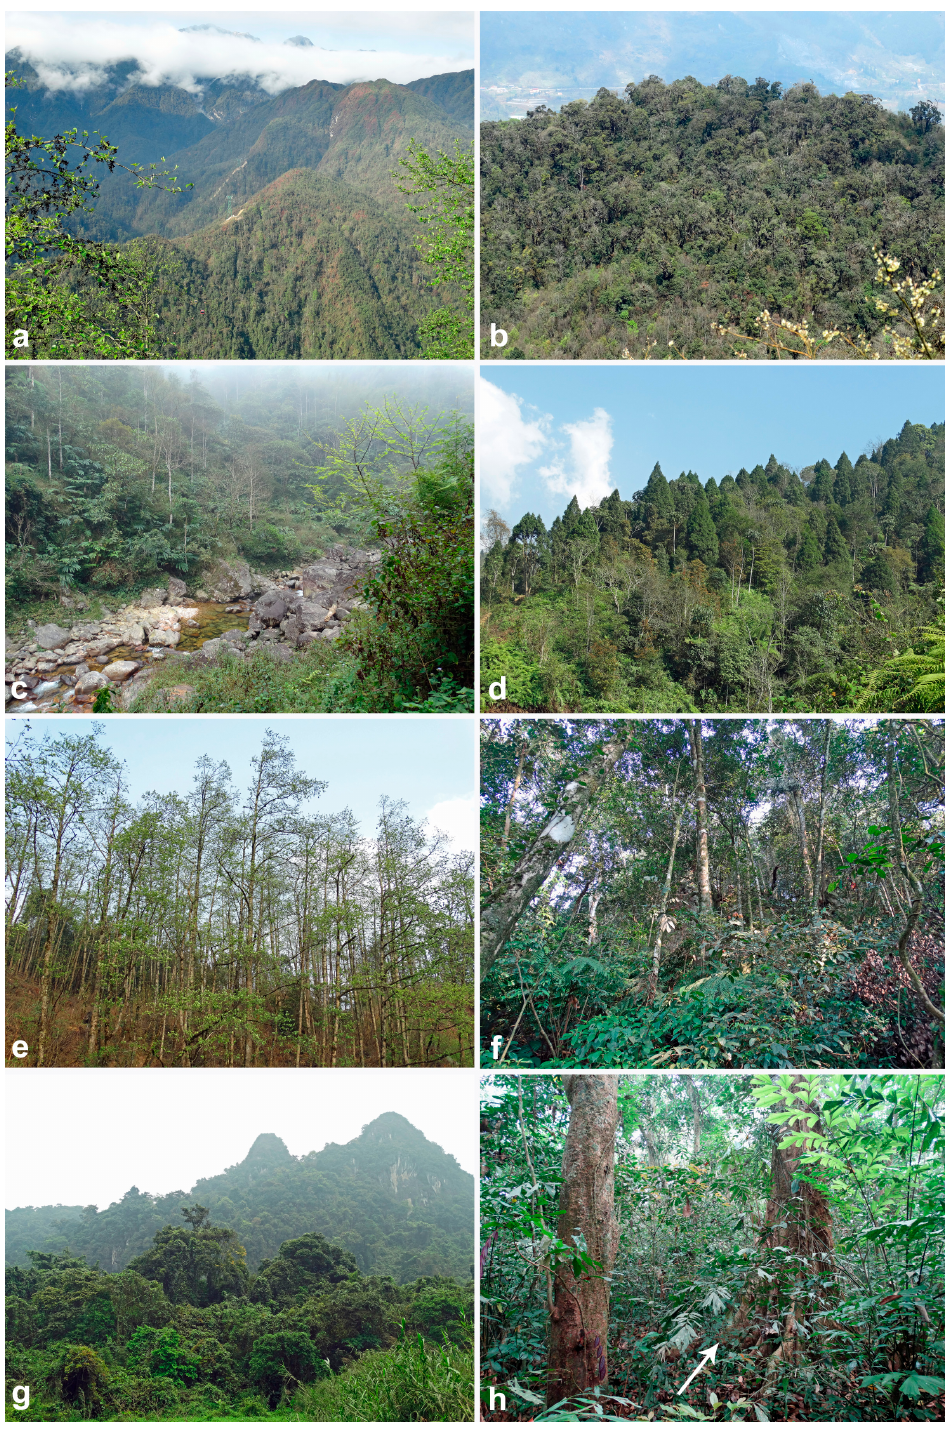
Figure 2. Representative forest stands and streams sampled in Vietnam; ( a ) Ho à ng Li ê n National Park around the Fansipan mountain with diverse montane evergreen cloud forests and montane evergreen broadleaved forests; ( b ) diverse montane evergreen cloud forest F04 in Ho à ng Li ê n National Park dominated by Fagaceae and Lauraceae species; ( c ) Cat Cat River (R10) running through a diverse montane evergreen forest in Ho à ng Li ê n National Park; ( d ) montane Chamaecyparis hodginsii — Quercus forest on Sau Chua mountain; ( e ) montane Alnus nepalensis stand on Xin Ch à i mountain; ( f ) diverse, suptropical, humid evergreen forest F15 in Ba V ì National Park; ( g ) Cuc Phuong National Park with diverse, tropical, evergreen lowland rainforests growing on limestone; ( h ) diverse, tropical, evergreen lowland rainforest stand F20. For GPS coordinates see Tables 1 and 2; for location of sites see Figure